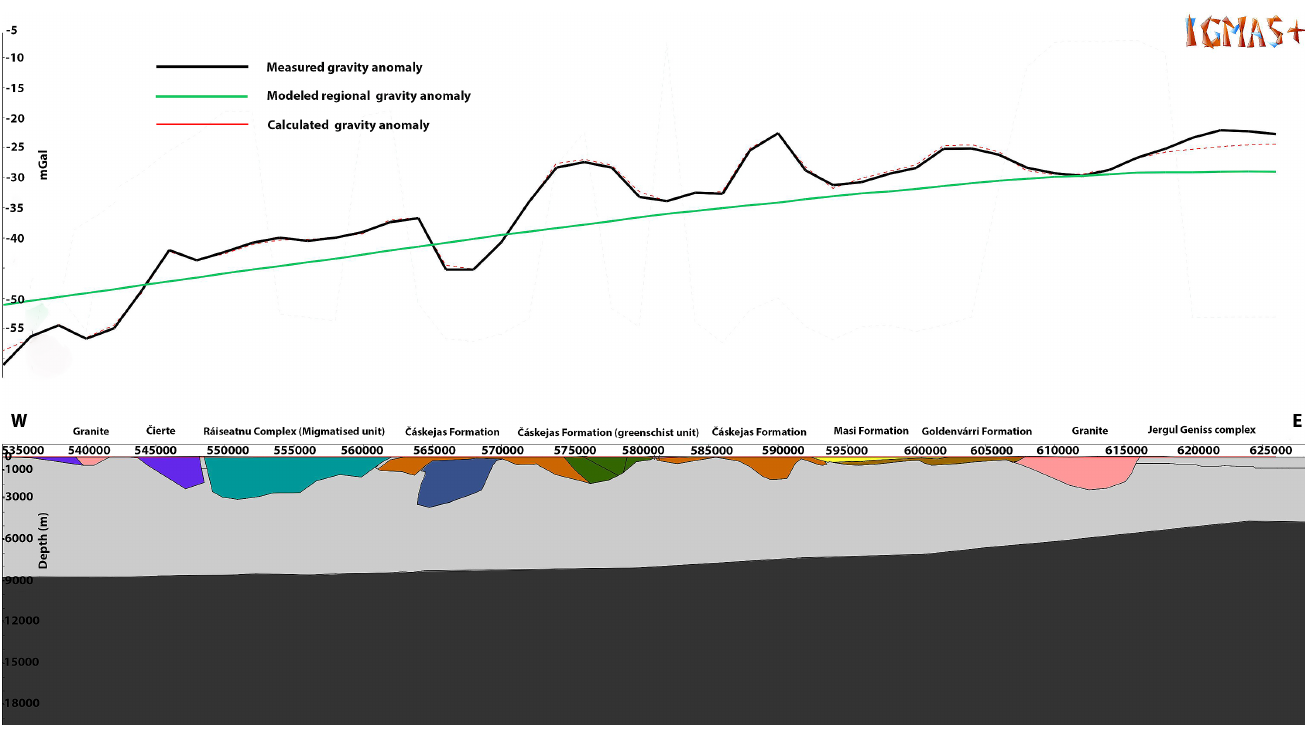
Figure 16. Selected vertical slice 3 (P3) through the 3D density/structural model in Fig. 12. The black line shows the measured data. The dashed red line is the modelled data and the green line shows the regional